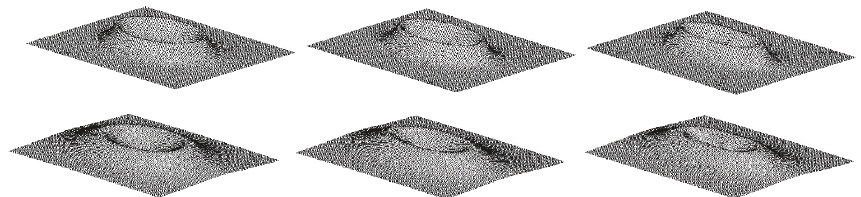
Figure 2: 3D images of elongated volcano-shaped QDs with different eccentricities; 𝑒 = 0, 0.5, and 1.0.